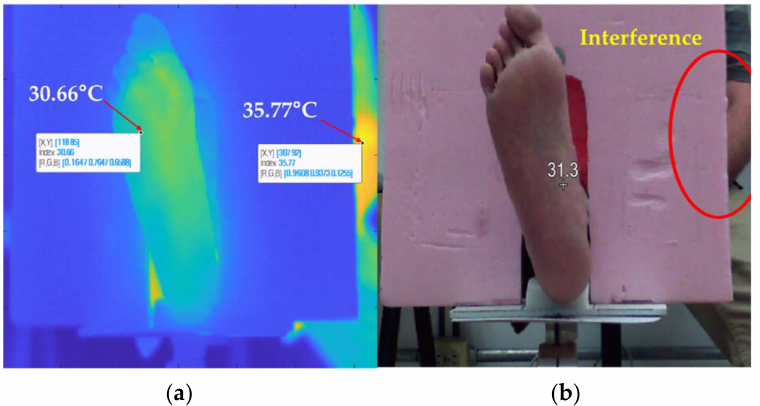
Figure 9. Color contrast mapping according to the warmest spot. ( a ) The hottest spot of the picture frame is located on the upper limb, which decreases the color contrast of the foot image. ( b ) The image was acquired by a wrongly aligned camera since the foam background should completely cover the volunteer’s body.